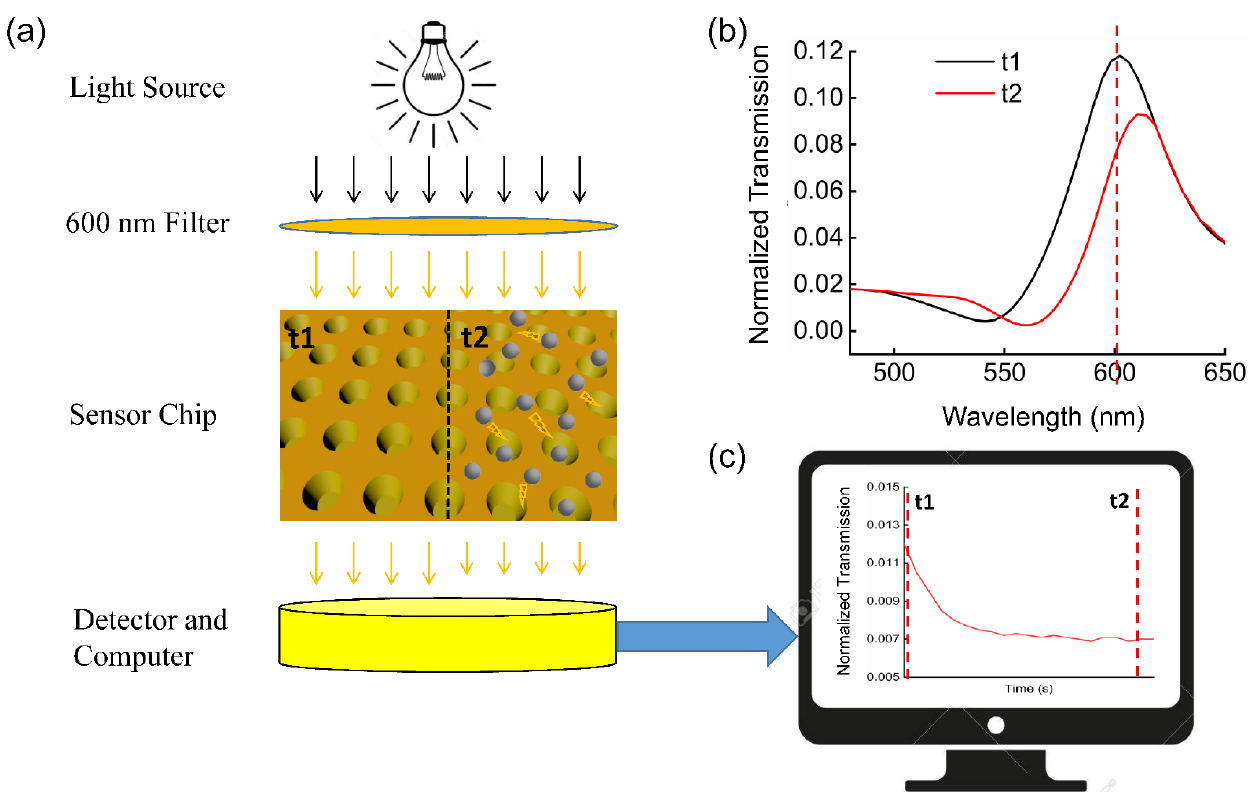
Figure 1. ( a ) The process of precipitation complex detection (t1: the spectrum before the complexes appear; t2: the spectrum after the complexes appear). ( b ) Spectra graph before and after the appear- ance of the compound detected by the spectrometer. ( c ) Detecting the process of complex formation by using 600 nm filter.